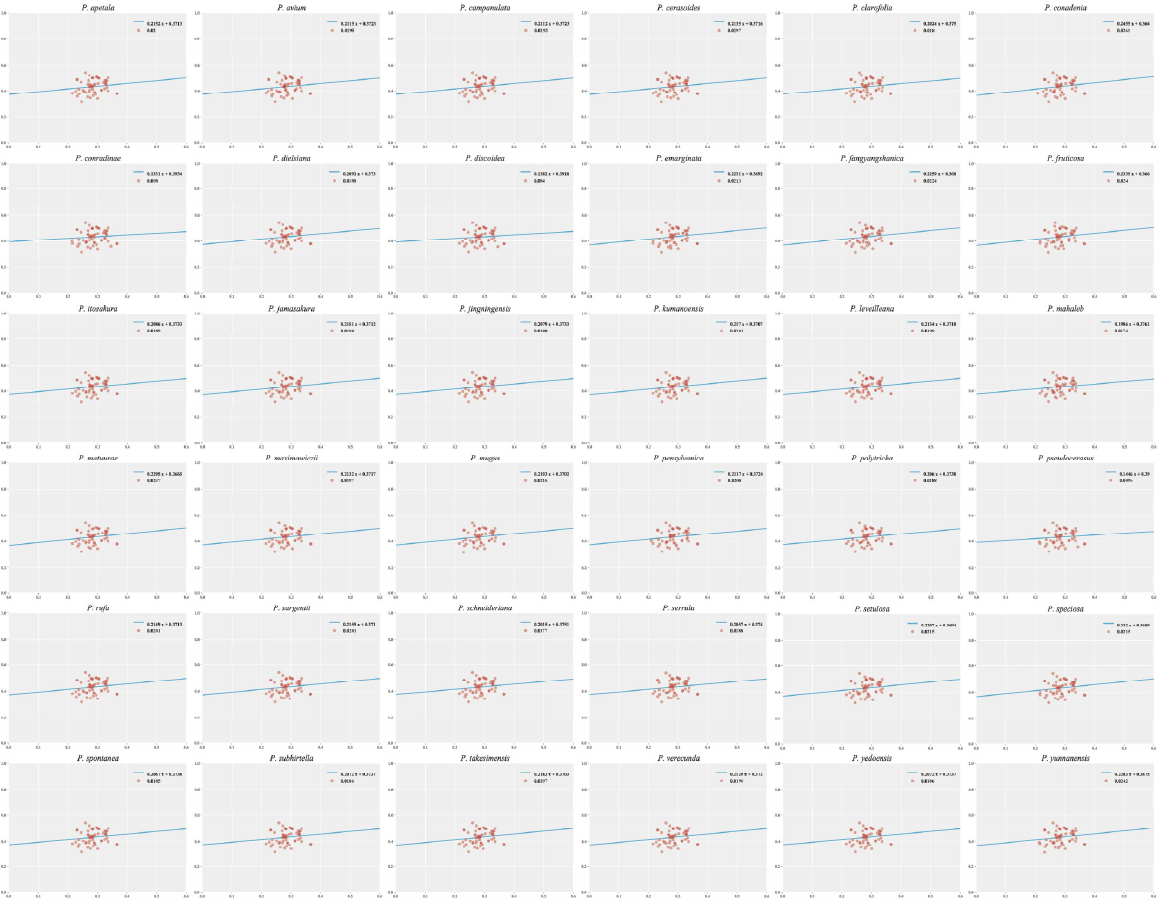
Figure 3. Neutrality plot analysis of 36 subg. Cerasus species.